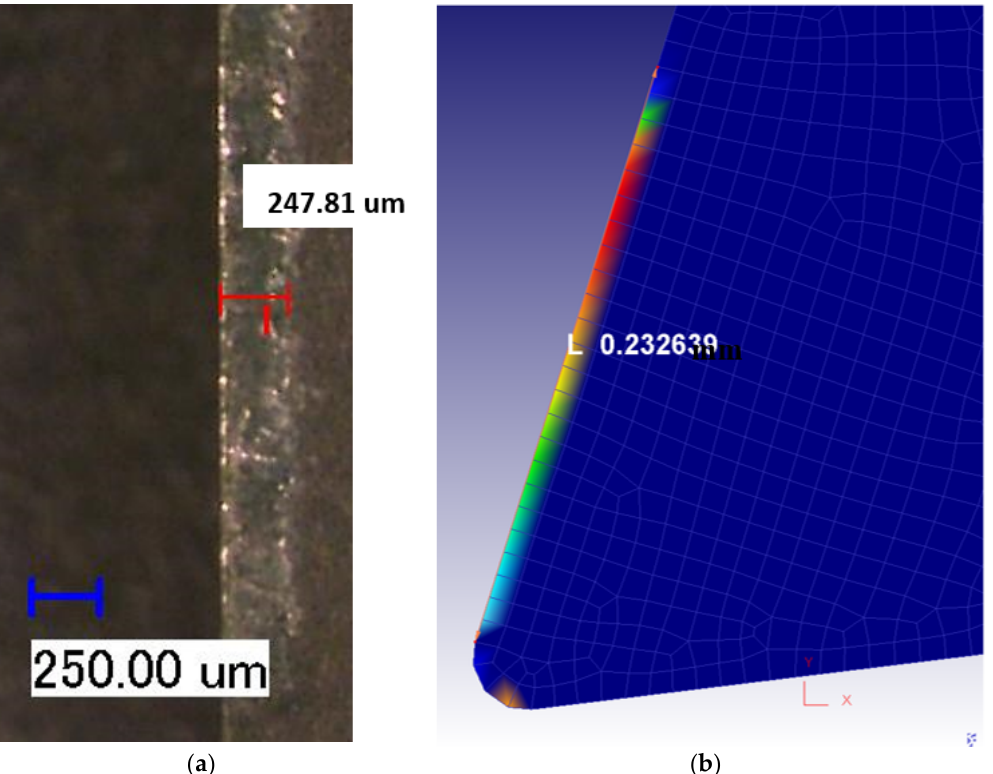
Figure 19. Crater wear for flood-coolant mode: ( a ) experimentally observed and ( b ) FE-simulated.